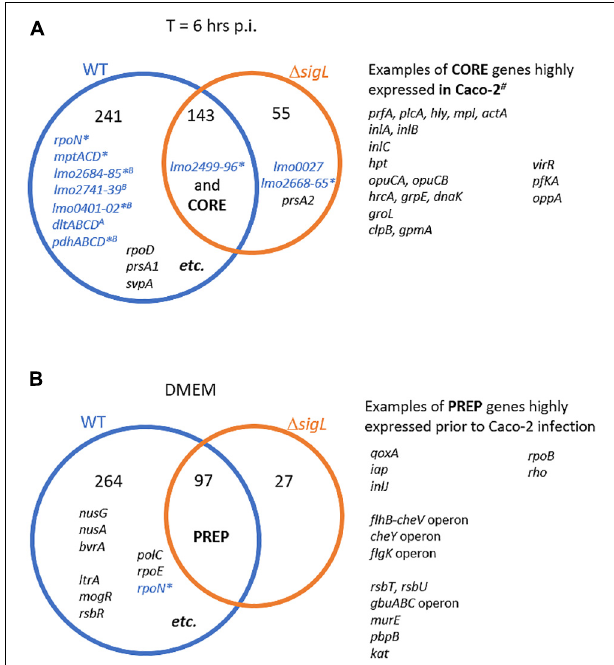
FIGURE 5 | Differentially expressed genes (DEGs) during the process of Caco-2 infection. (A) Venn diagram showing numbers and examples of genes highly expressed inside Caco-2 during intracellular life cycles ( T = 6 h PI). “Core” genes are highly expressed inside Caco-2 in both WT and (cid:49) sigL strains. Detailed information is shown in Supplementary Tables 4, 6 . Gene names in blue indicate they are SigL-dependent. ∗ and B indicate gene/operon with putative SigL-dependent and putative SigB-dependent promoter, respectively (Chaturongakul et al., 2011). The # indicates genes overlapping with those reported as intracellularly expressed inside Caco-2 cell line in the study by Joseph et al. (2006). (B) Venn diagram showing numbers and examples of genes highly expressed in DMEM as extracellular Listeria monocytogenes prior to in vitro infection. “Prep” genes are highly expressed in DMEM in both WT and (cid:49) sigL strains. Detailed information is shown in Supplementary Tables 3, 5